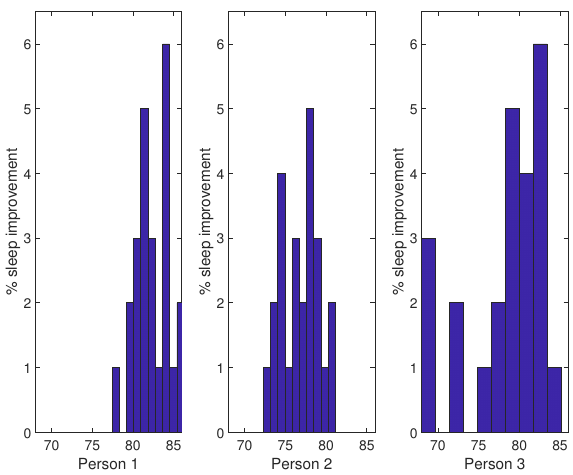
Figure 24. Histogram for three random people in the sample.